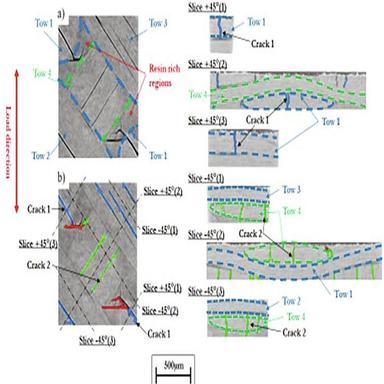
Description of damage in first ply at interweaving regions. Specimen tested in 2 bar O2 after 550 k cycles .